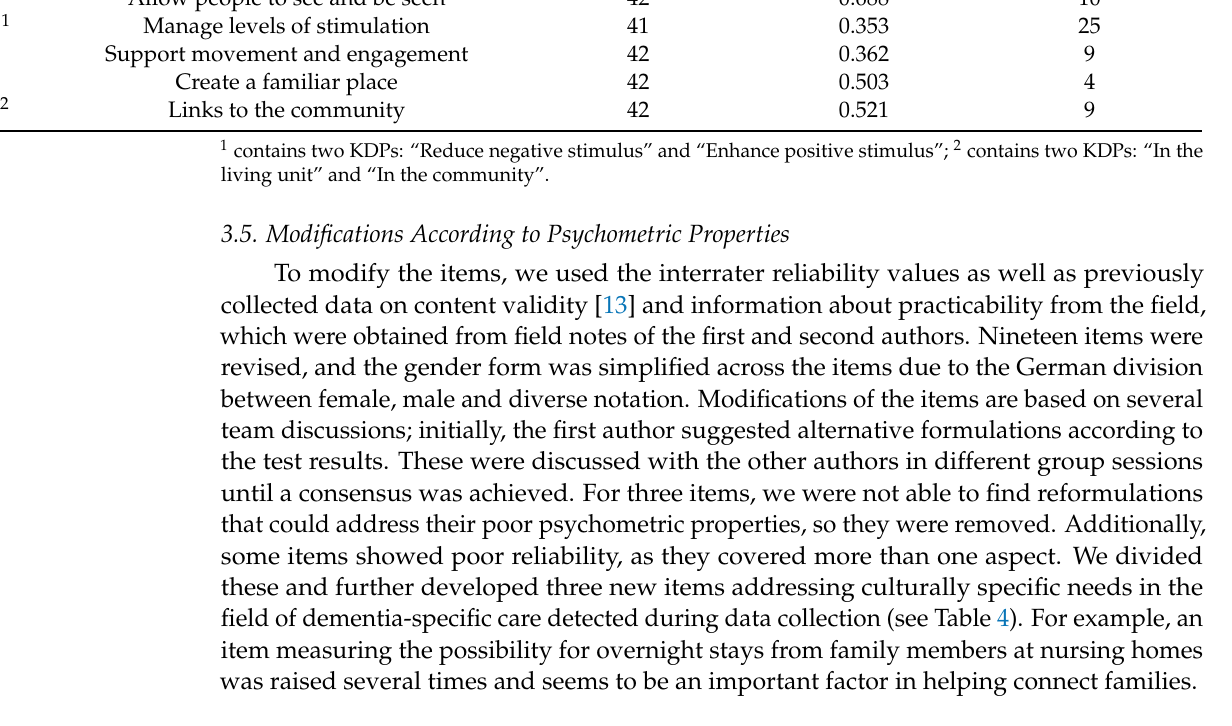
Table 4. Overview of main item